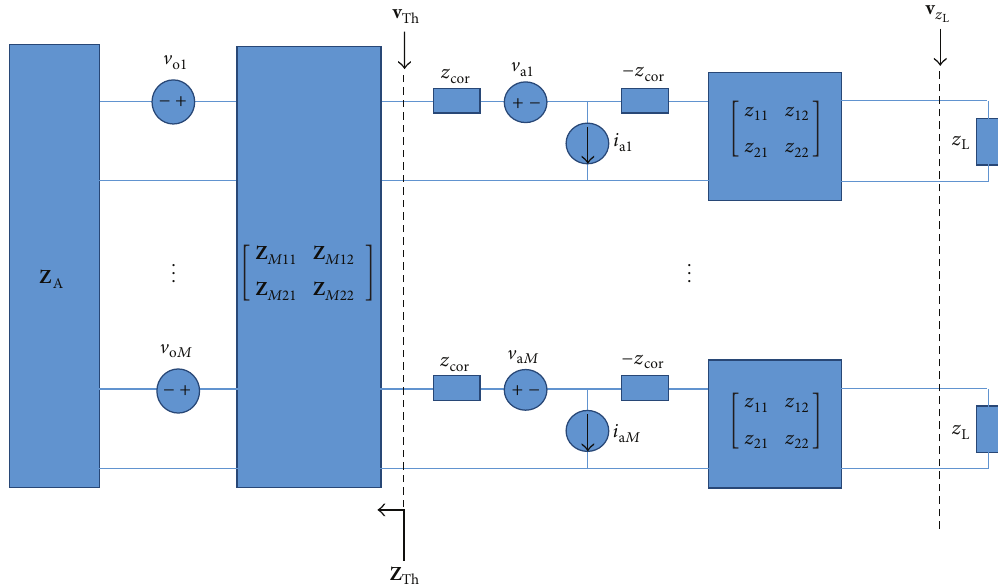
Figure 1: Receiver circuit model. According to Rothe-Dahlke noise model, any two-port circuit with internal noise sources can be represented by a 2 × 2 equivalent network impedance matrix, noise voltage, and current sources V a 𝑚 , 𝑖 a 𝑚 , and correlation impedance 𝑧 cor . This figure is derived from Figure 2 of the paper in